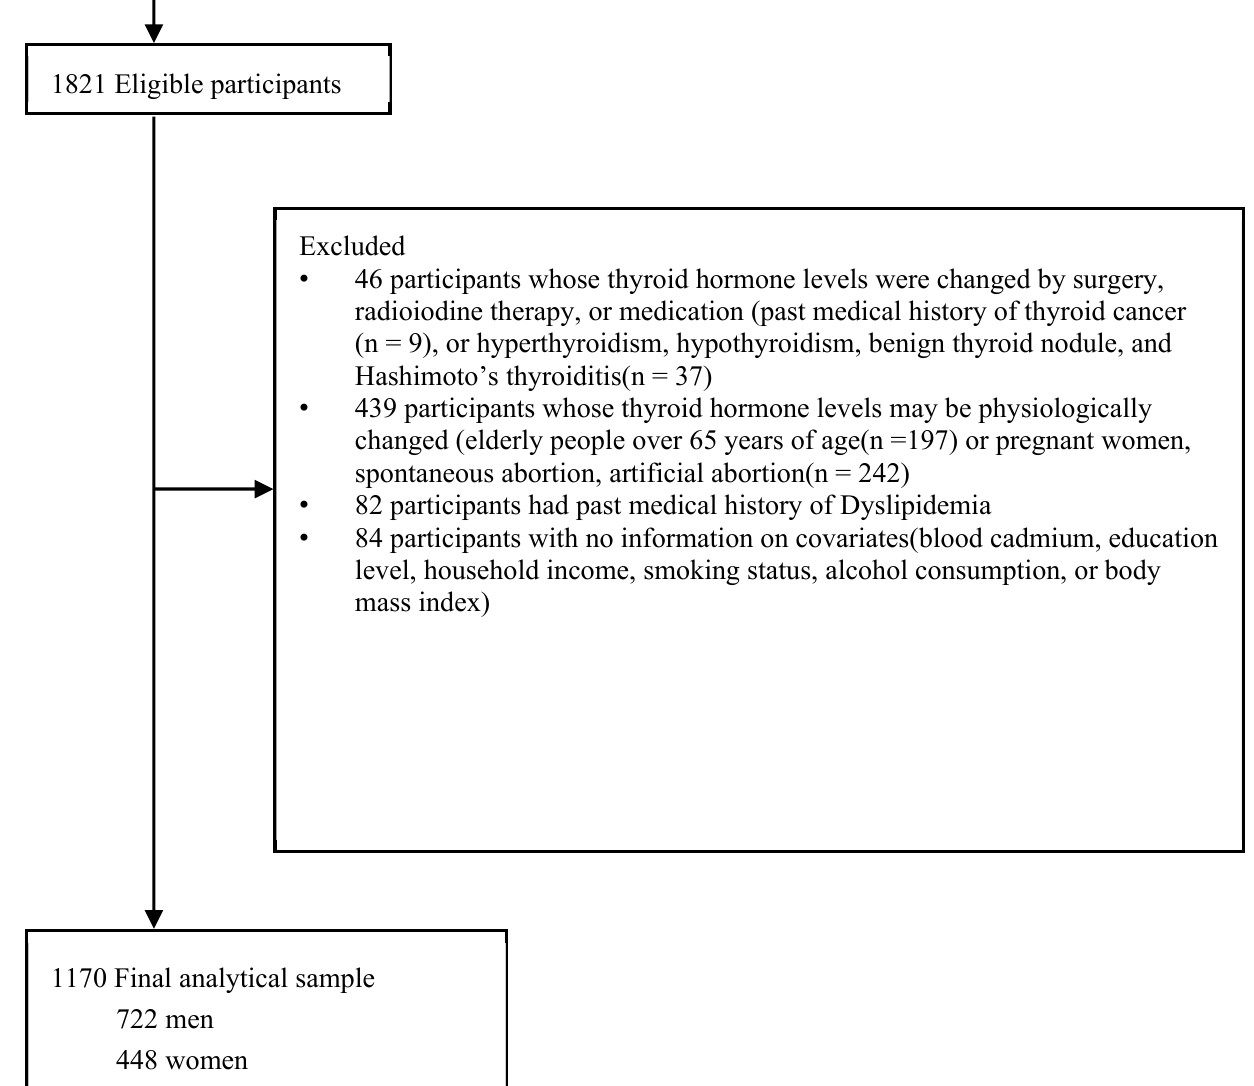
Figure 1. Flow diagram showing study sample derivation. Abbreviations: KNHANES, Korean National Health and Nutrition Examination